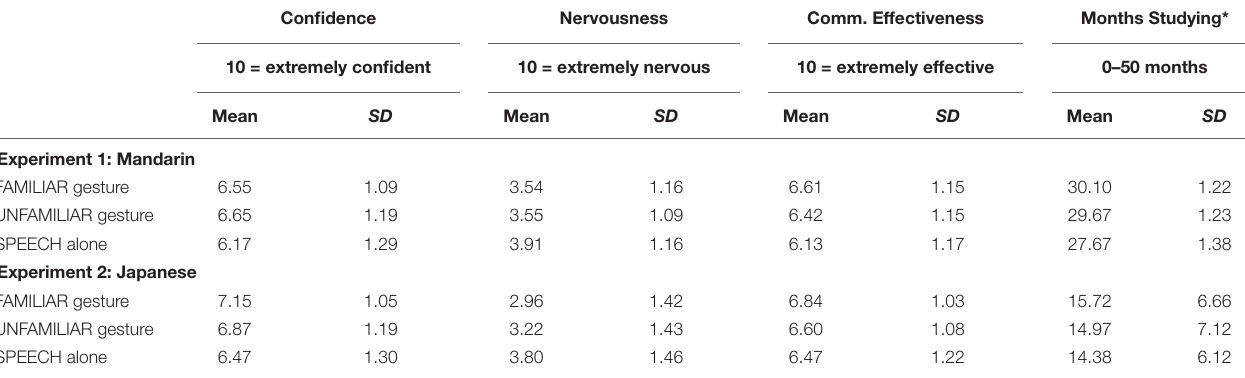
TABLE 2 | Means and standard deviations of native speaker responses in the L2 “Learner” evaluation. Confidence Nervousness Comm. Effectiveness